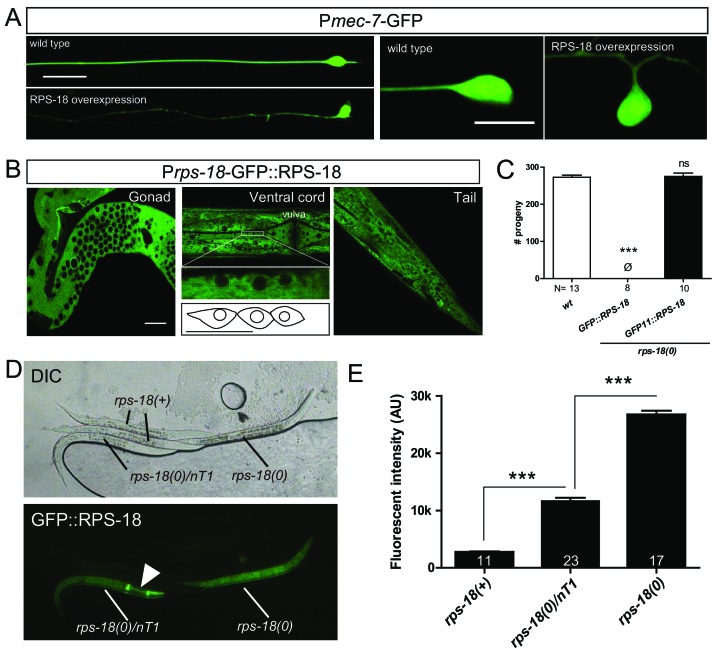
GFP::RPS-18 visualizes ribosomes in the whole body.(A) RPS-18 overexpression in mechanosensory neurons with juEx5815[Pmec-4-RPS-18] caused abnormal axon (left panels) and soma (middle panels) morphologies. ALM neurons were visualized by muIs32[Pmec-7-GFP]. Scale bars: 20 and 10 µm in left and right panels, respectively. (B) Representative images of the indicated regions of juSi83[GFP::rps-18]-expressing worms in rps-18(0)/nT1 background at the young adult stage. All images were taken from the live animals except for the gonad, which was dissected out from the body. The magnified image in the middle shows the cell bodies of motor neurons. Scale bars: 20 µm, 10 µm in the magnified image. (C) Brood size of worms for genotypes indicated. Single-copy transgenes, juSi83[GFP::rps-18] or juSi94[GFP11::rps-18], were used to rescue the sterility of rps-18(0). N: numbers of parental worms. Error bars: S.E.M. Statistics: 1-way ANOVA, compared to the wild type. ns: not significant (p>0.05), p***<0.001. (D) Differential interference contrast (DIC) and fluorescent images of juSi83-expressing worms at the L3 stage in the wild-type, heterozygous (rps-18(0)/nT1), or homozygous (rps-18(0)) background. Arrowhead: pharyngeal GFP in the nT1 balancer. (E) Quantification of fluorescence intensity of juSi83-carrying worms in the indicated backgrounds. Numbers of worms are shown in the bars. Error bars indicate S.E.M. Statistics: One way ANOVA, ***p<0.001.